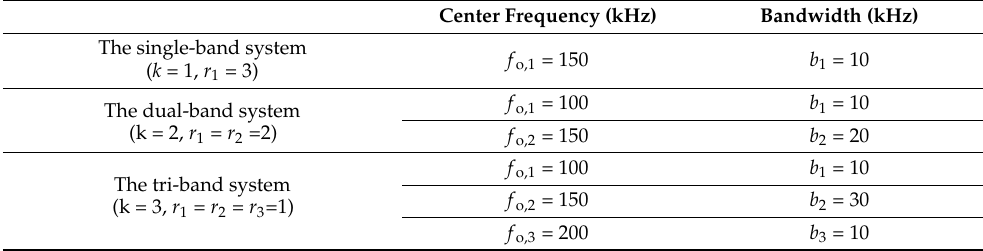
Table 2. The given spectrum parameters.